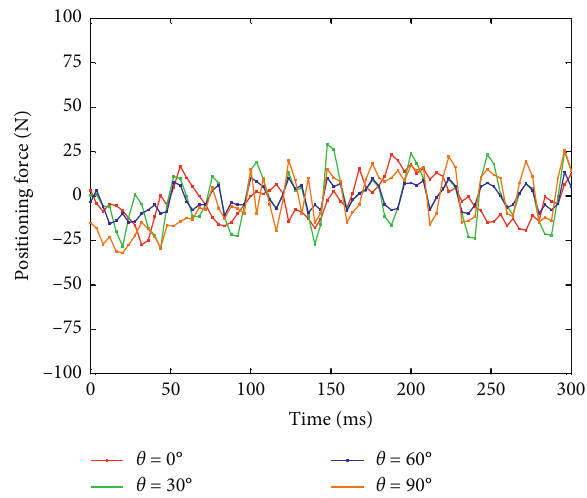
Figure 12: Cogging force at different edge radians.